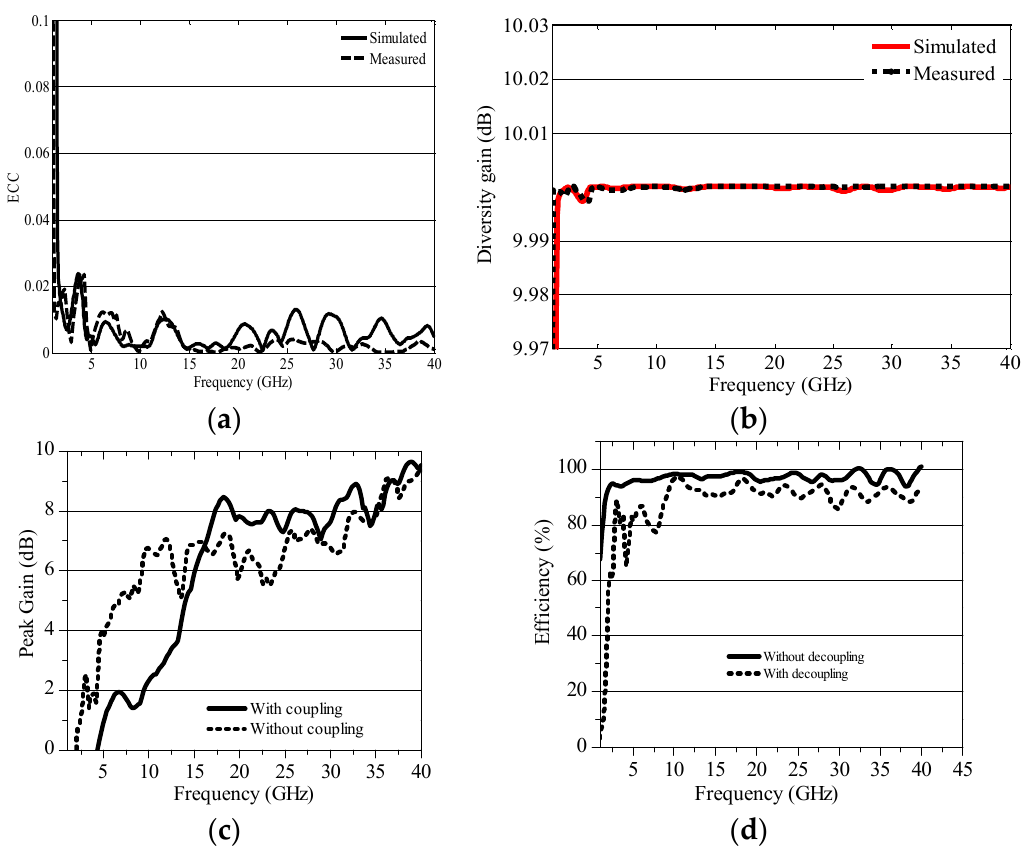
Figure 9. The plot of ( a ) envelope correlation coefficient ( b ) diversity gain ( c ) peak gain verses frequency and ( d ) efficiency.